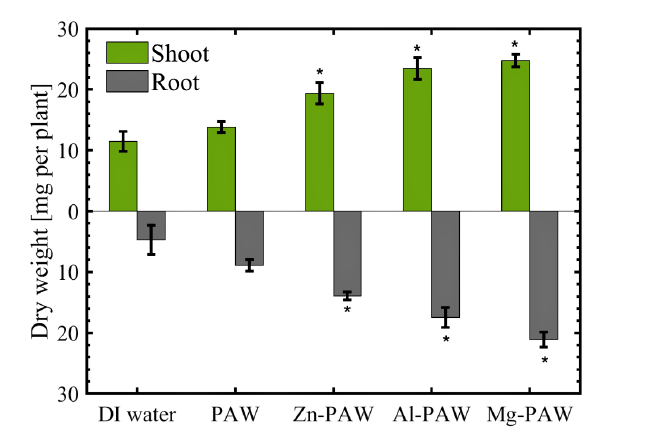
Figure 6. Average dry weight of shoot and roots after the 10th day of soaking in DI water, PAW, PAW with Zn (Zn-PAW), PAW with Al (Al-PAW), or PAW with Mg (Mg-PAW). The symbol ∗ is for t-test result above the 5% significance